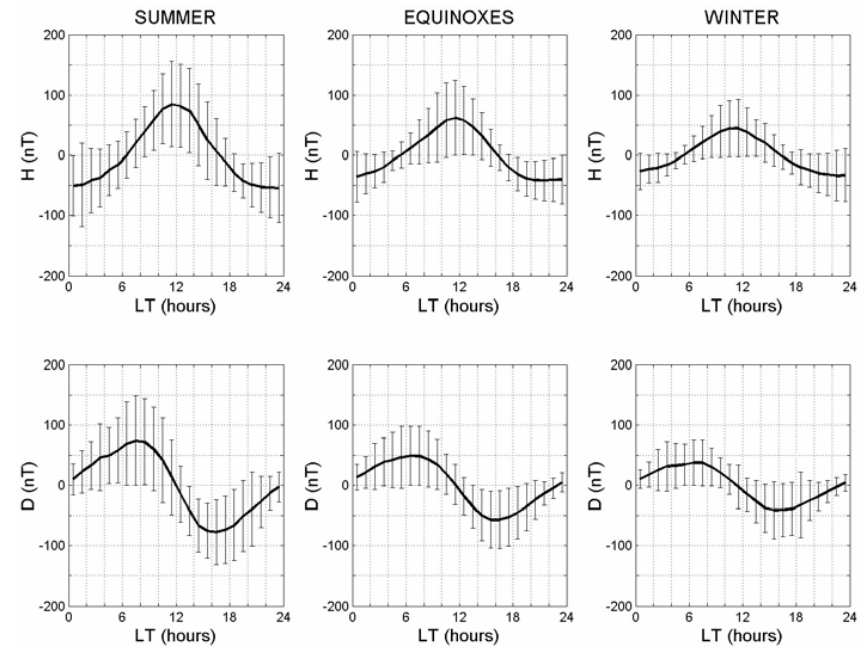
Fig. 4. Daily distribution of the average hourly values and their standard deviation for the H and D components, considering separately the three Lloyd seasons.